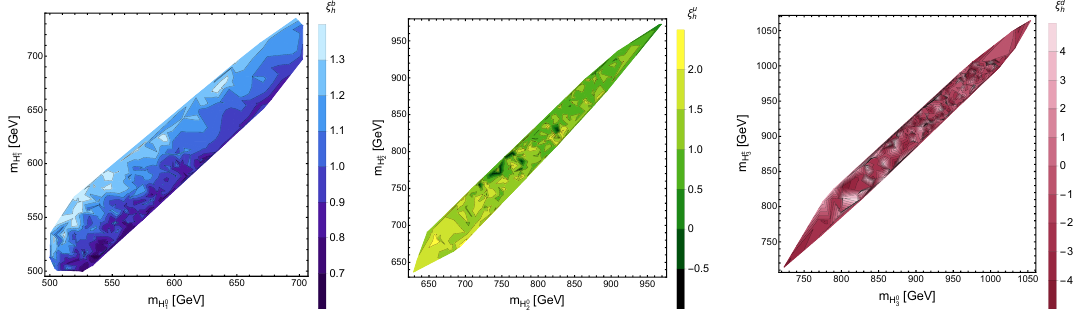
Figure 4 . Correlation plots of the scalar masses. In each (cid:12)gure we have contour plotted the value of the e(cid:11)ective couplings, in the allowed 3 (cid:27) ranges, between the fermions and the SM-like Higgs. In all cases (cid:24) t = 1, m h = 125 GeV, and equal plots can be found by replacing H 0 h behaviour in the couplings can be associated to the large amount of